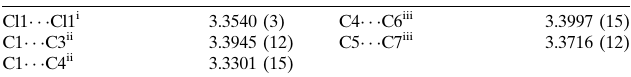
Selected interatomic distances (A˚ ).